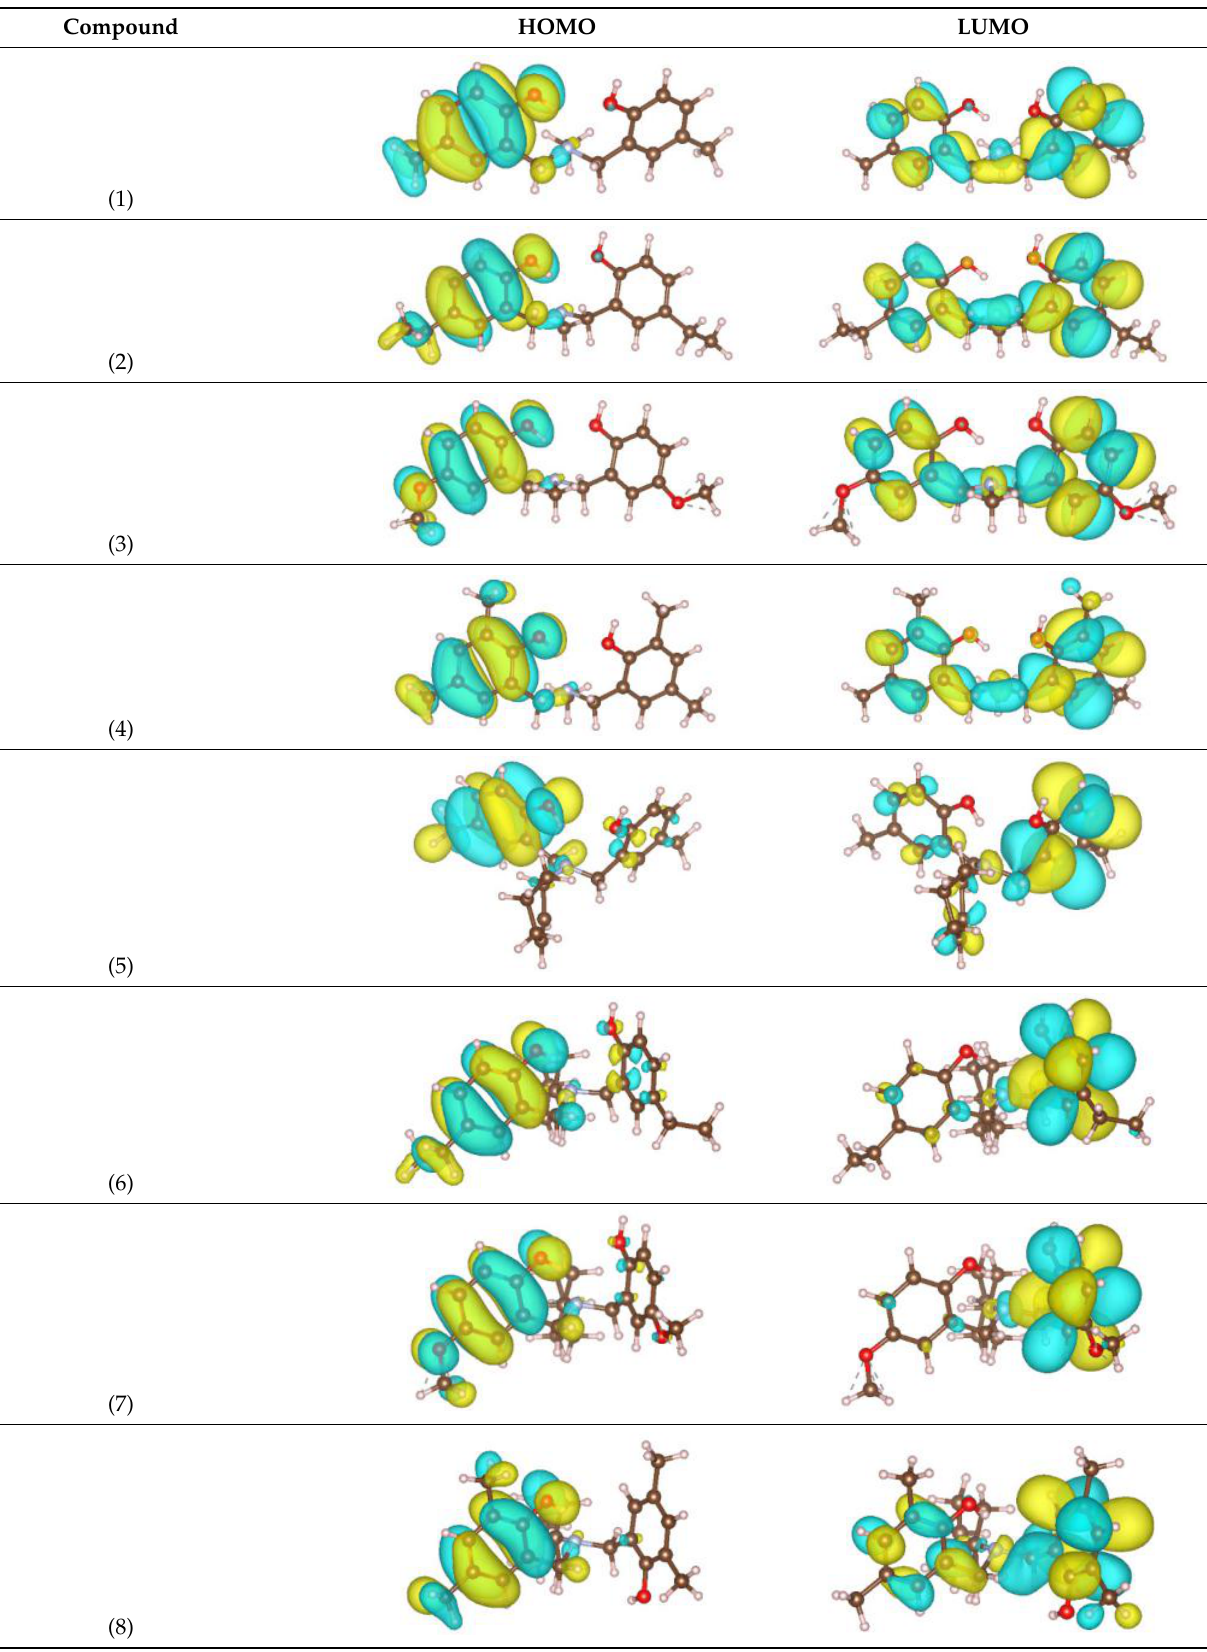
Table 8. Visualization of the HOMO and LUMO of the dihydro-benzoxazine dimers (1) to (8) in acetonitrile. The isosurface is